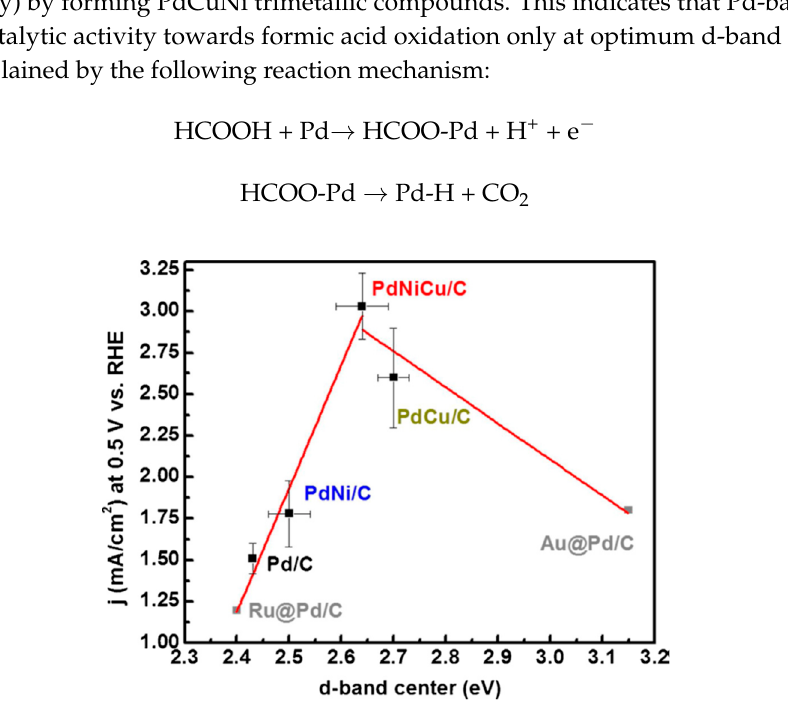
Figure 2. Relationship between the d-band center values and current densities of various Pd-based catalysts at 0.5 V (versus RHE). Reproduced with permission [49]. Copyright 2016, Elsevier.